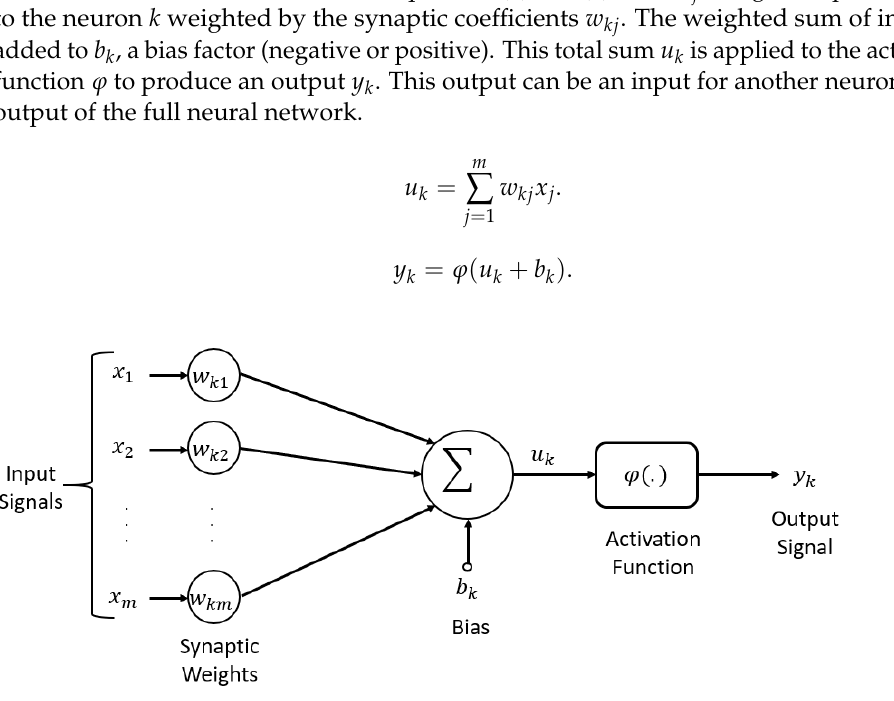
Figure 4. A standard schematic representation of an Artificial Neural